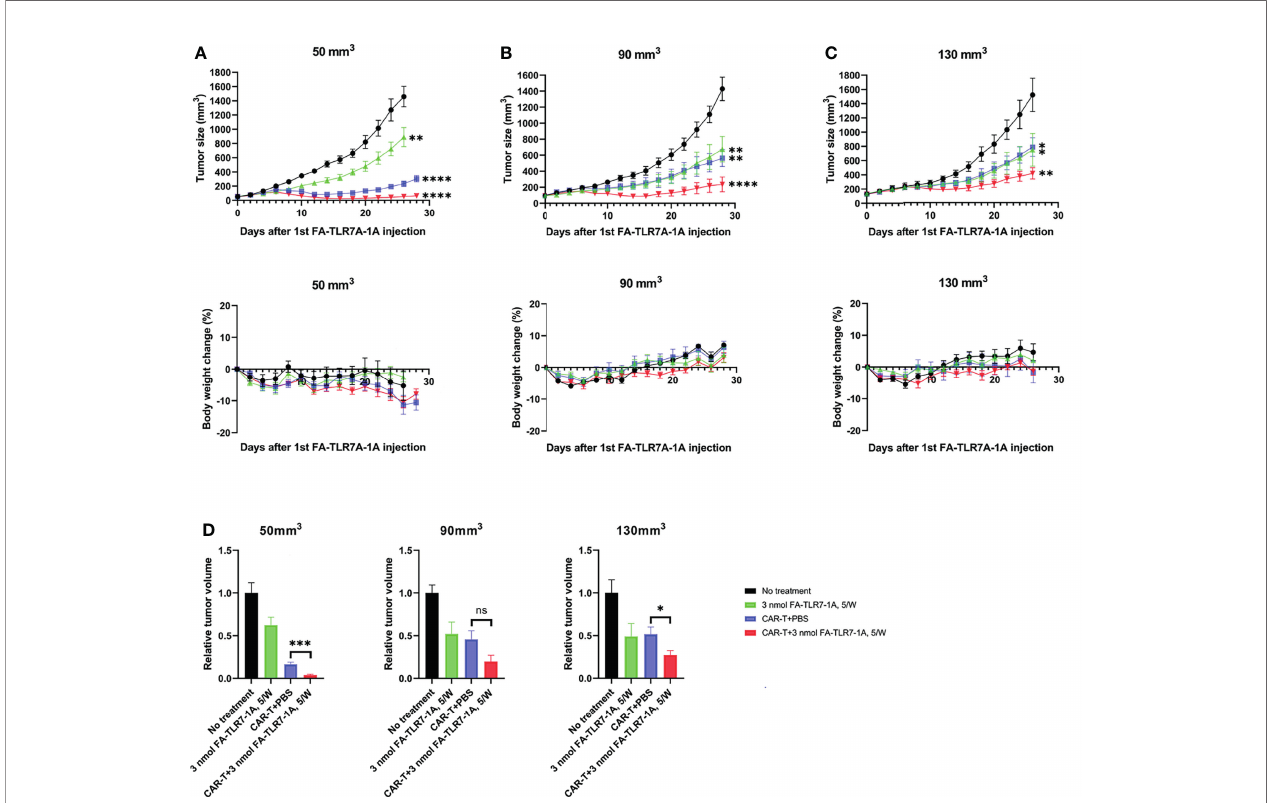
FIGURE 4 | The effect of tumor size on the ability of FA-TLR7-1A to enhance anti-CD19 CAR T cell therapy of solid 4T1-mCD19 tumors. Analysis of tumor size and body weight change of mice in which treatments started when the average tumor sizes reached (A) 50 mm 3 , (B) 90 mm 3 , and (C) 130 mm 3 . (D) Comparison of the relative tumor sizes on day 26 after initiation of therapy. The number of mice per treatment group were as follows: for mice with 50mm 3 tumors: “ No treatment ” , n=5; “ 3 nmol FA-TLR7-1A, 5W ” , n=6; “ CAR T+PBS ” , n=6; “ CAR T+3n mol FA-TLR7-1A, 5W ” , n=9. For mice with either 90mm 3 or 130mm 3 , n=5 for all the groups. Mean ± SEM. Statistical signi fi cance between multiple groups was determined using a 1-way ANOVA followed by a Tukey post hoc analysis. Statistical signi fi cance between two groups was determined using an unpaired two ‐ tailed t ‐ test (*P < 0.05, **P < 0.01, ***P < 0.001, ****P < 0.0001, ns, not signi fi cant P ≥